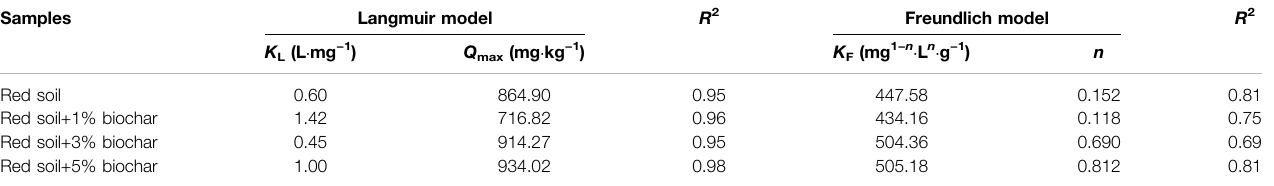
TABLE 2 | The parameters of Freundlich and Langmuir isotherms for P absorption by the pure and biochar-amended red soils. Samples